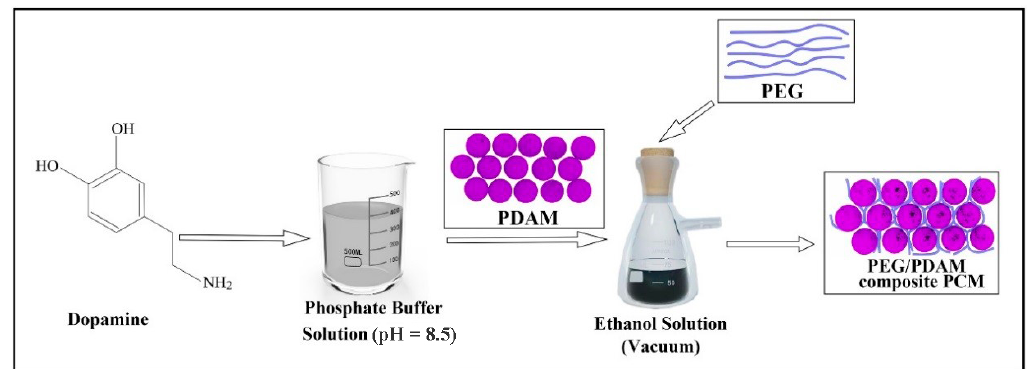
Figure 1. Schematic representation of the preparation process of polyethylene glycol (PEG)/polydopamine microspheres (PDAMs).